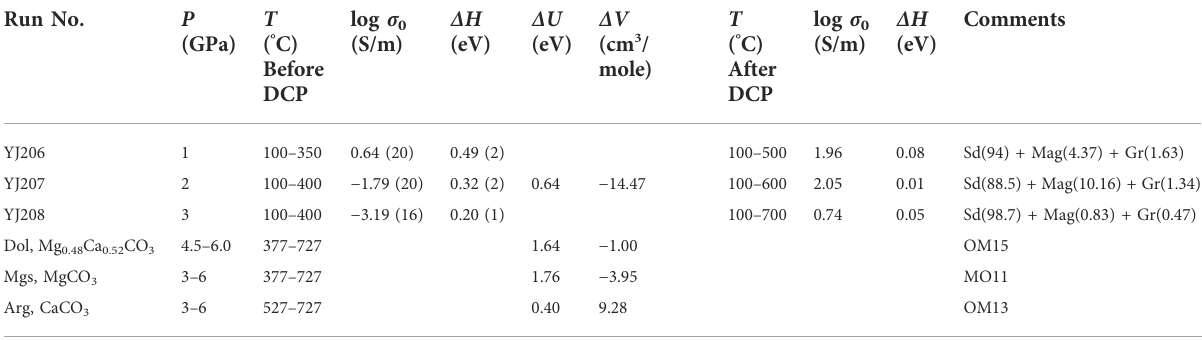
TABLE 1 Experimental conditions and the Arrhenius fi tting parameters for the electrical conductivity of siderite (Fe 0.88 Mn 0.03 Mg 0.09 CO 3 ) before decomposition and after partly decomposition as well as previous results of other carbonate minerals. Run